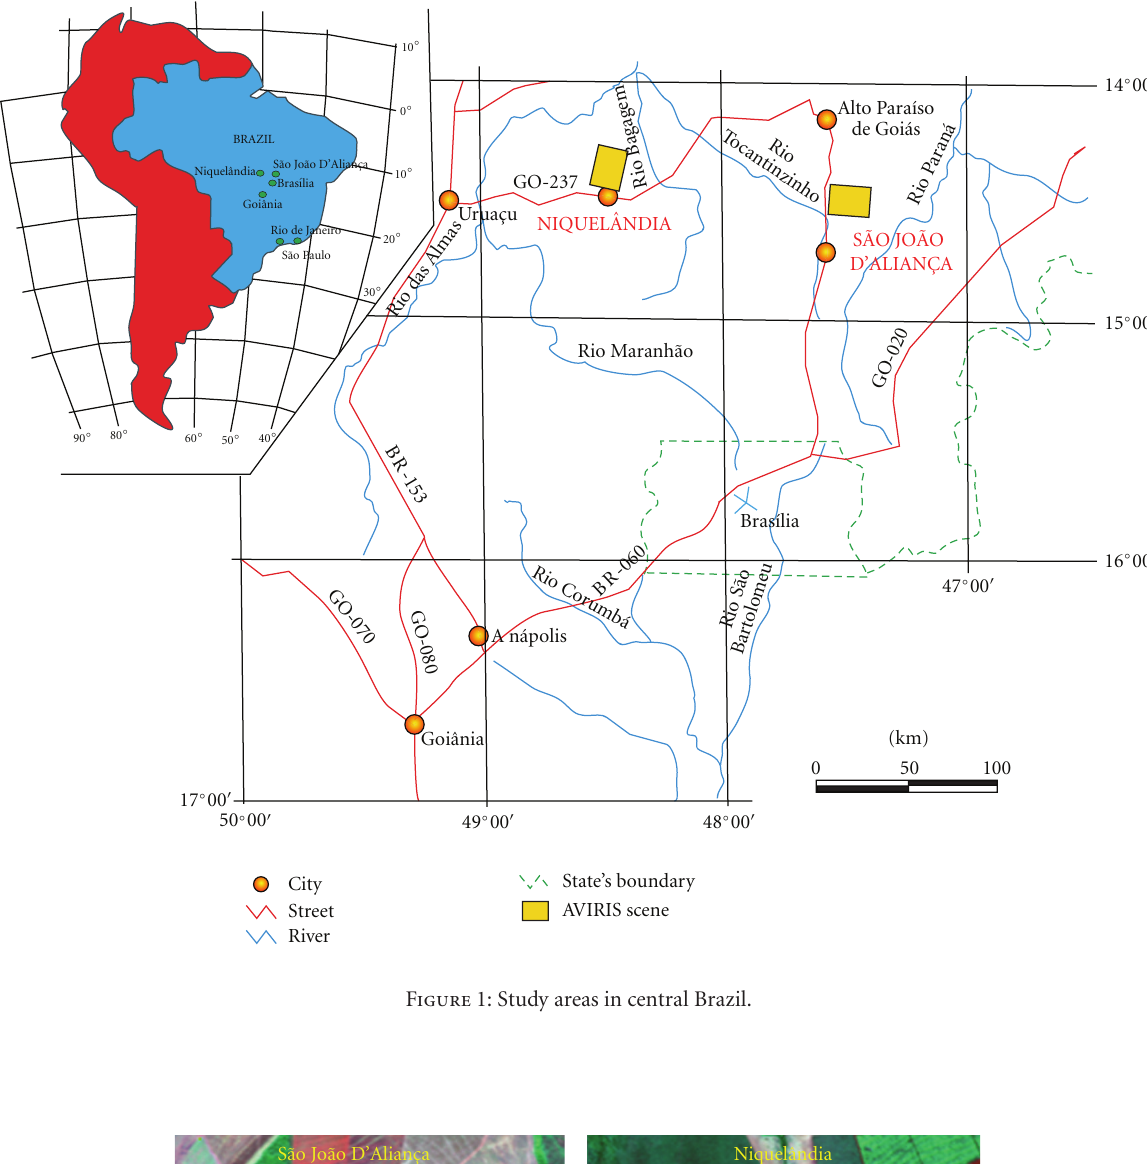
Figure 1: Study areas in central Brazil.